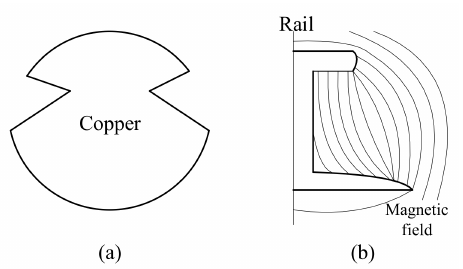
Figure 2. Irregularly shaped wires: ( a ) CW, ( b ) rail.